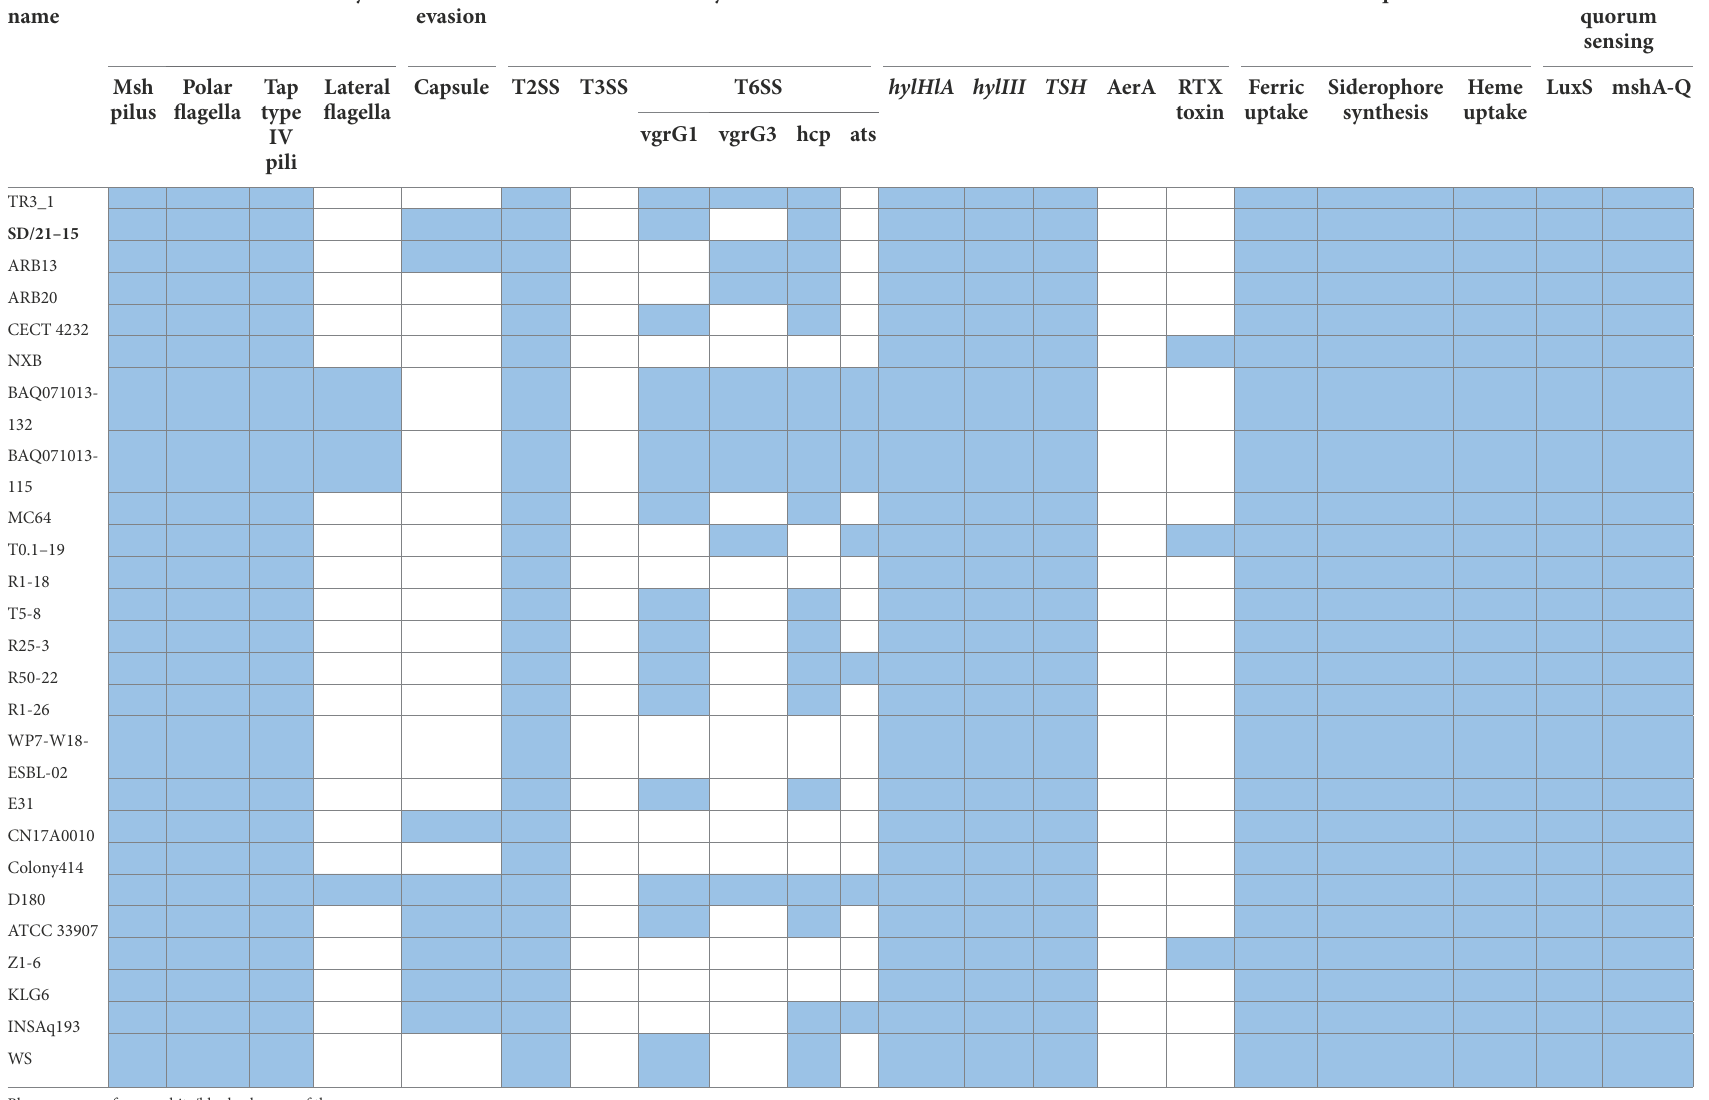
TABLE 2 Comparison of virulence genes in Aeromonas media